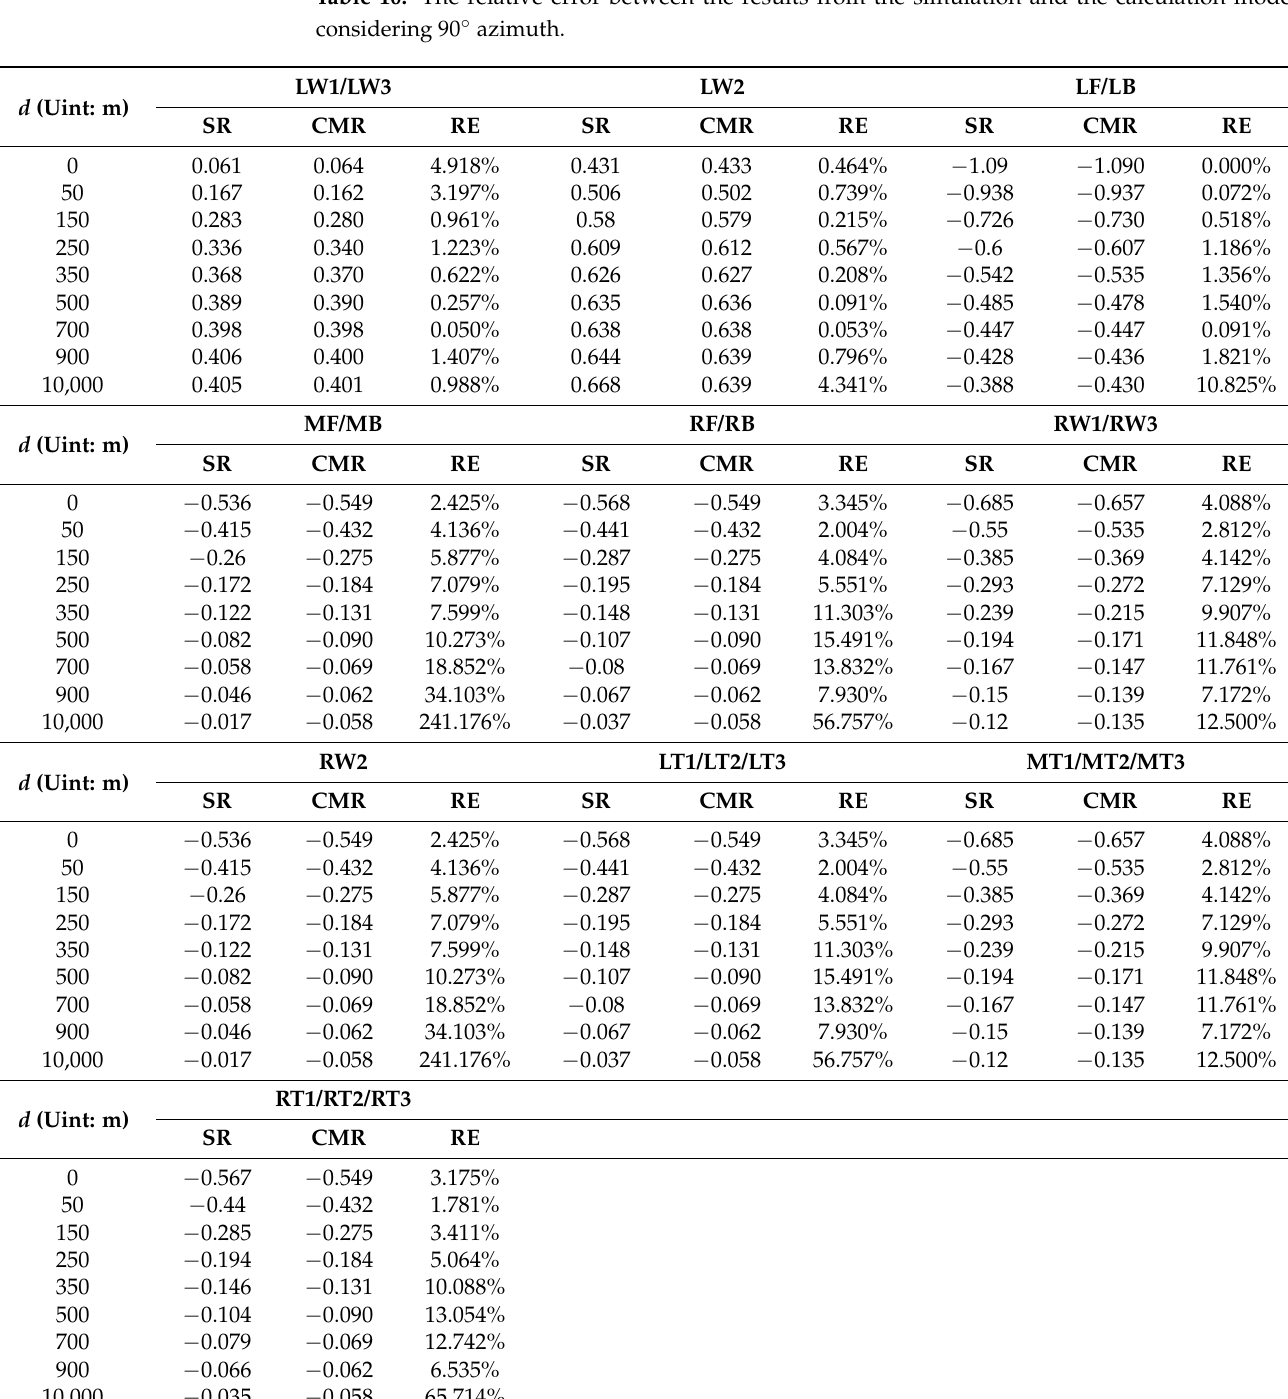
Table 10. The relative error between the results from the simulation and the calculation model considering 90 ◦